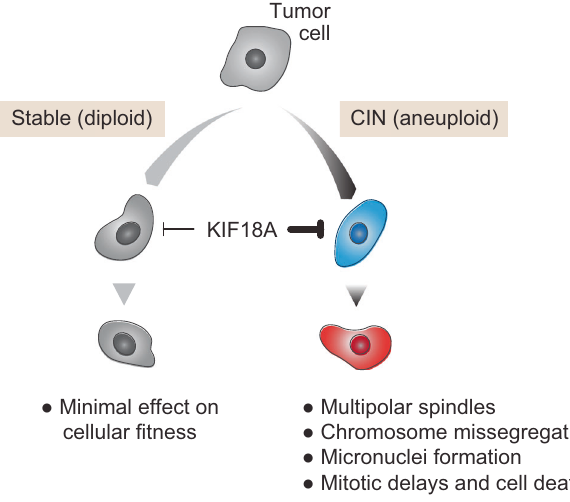
Fig. 1 KIF18A dependency in CIN tumor cells. CIN tumor cells (via one of several forms of ploidy defects) are uniquely dependent on KIF18A, the inhibition of which leads to myriad phenotypic abnormalities absent in diploid